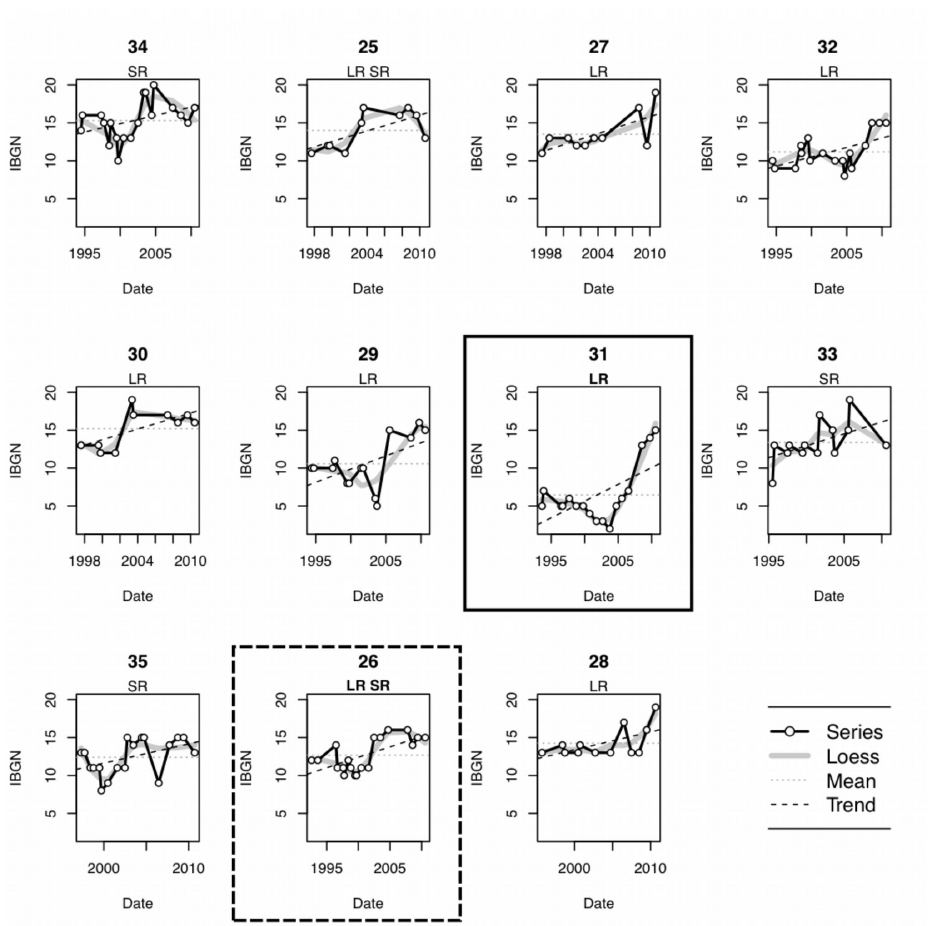
Figure 3. Plots of the eleven series for which the three tests, taken individually, gave different outputs. The two box- plots refer to unclassified series after the FDR correction. Black line with white dots are the observed IBGN values, light dotted line is the mean of the series, bold dashed line is the linear regression, bold light grey line is the LOESS fitting of the